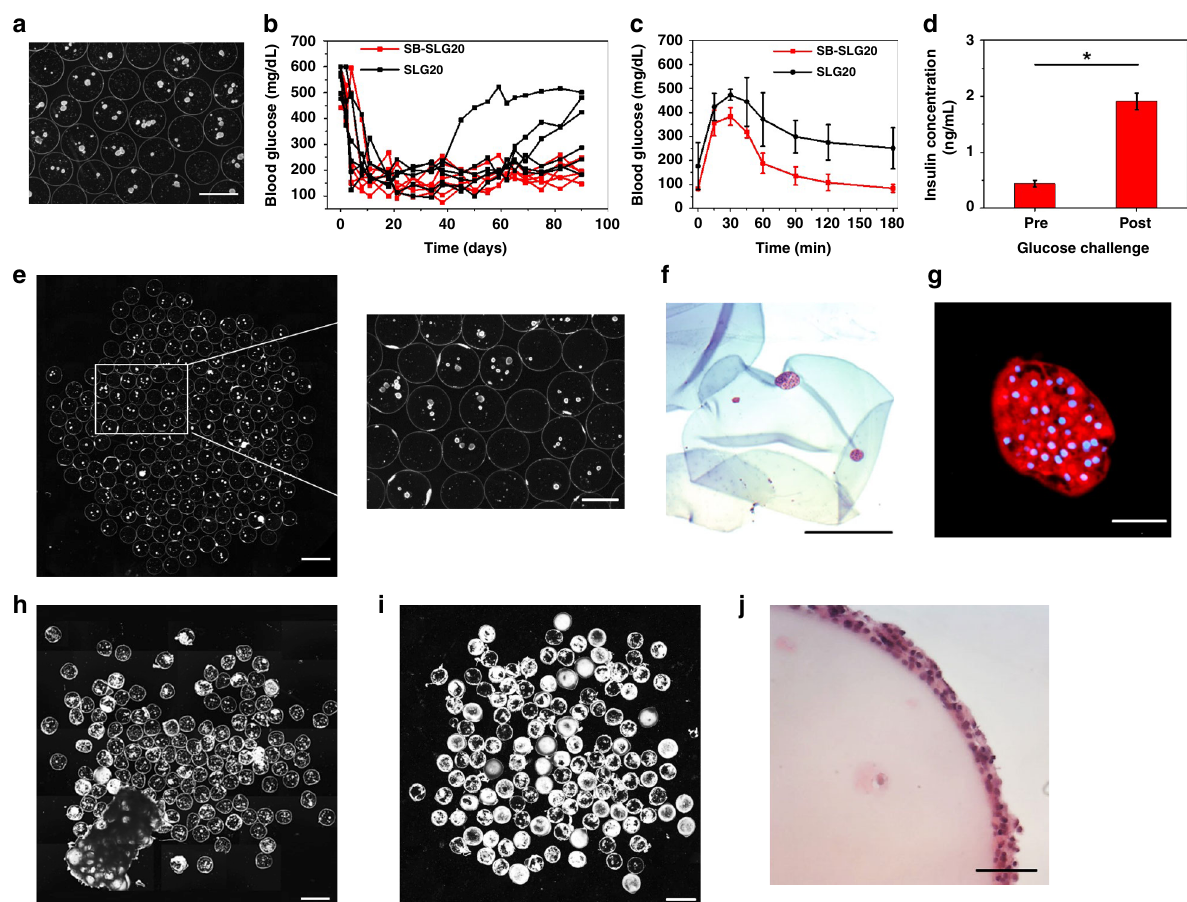
Fig. 5 SB-SLG20 microcapsules improve diabetes correction in mice in a 90-day study. a A dark- fi eld phase contrast image of SLG20 microcapsules encapsulating rat islets before transplantation. Scale bar, 1 mm. b Blood glucose concentrations of mice ( n = 6 per treatment group). c Intraperitoneal glucose tolerance test (IPGTT) before retrieval ( n = 3). d Ex vivo glucose-stimulated insulin secretion (GSIS) of retrieved islet-containing SB-SLG20 microcapsules, n = 3, Mean ± SEM, * P < 0.05. e A dark- fi eld phase contrast image of retrieved islet-containing SB-SLG20 microcapsules ( n = 6; see Supplementary Fig. 35 for complete data. Scale bars, 2 mm on the left and 1 mm on the right). f An H&E stained cross-sectional image of retrieved islet- containing SB-SLG20 microcapsules. Scale bar, 500 μ m. g Immunohistochemical staining of a rat islet in a retrieved SB-SLG20 microcapsule. Insulin is stained red and nuclei are stained blue (Scale bar, 50 μ m). h , i Dark- fi eld phase contrast images of retrieved islet-containing SLG20 microcapsules from the normoglycemic mouse group ( h ) and failed ones ( i ). ( n = 6; scale bar = 2 mm; see Supplementary Fig. 37 for complete data). j An H&E stained